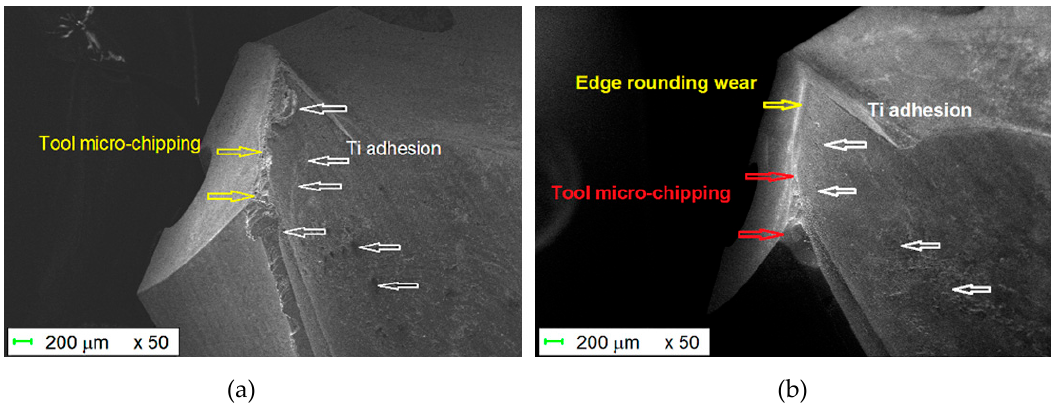
Figure 14. ( a ) After 25 holes in the stack, presence of adhesion of titanium alloy; ( b ) after 25 holes in the stack and passing through the CFRP, the adhered titanium has strongly decreased.